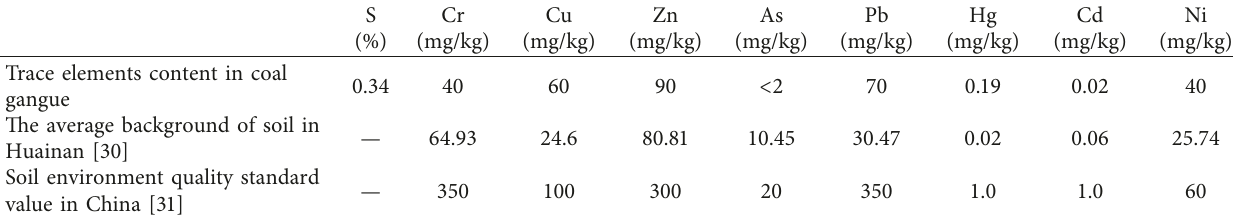
Table 2: Coal gangue trace